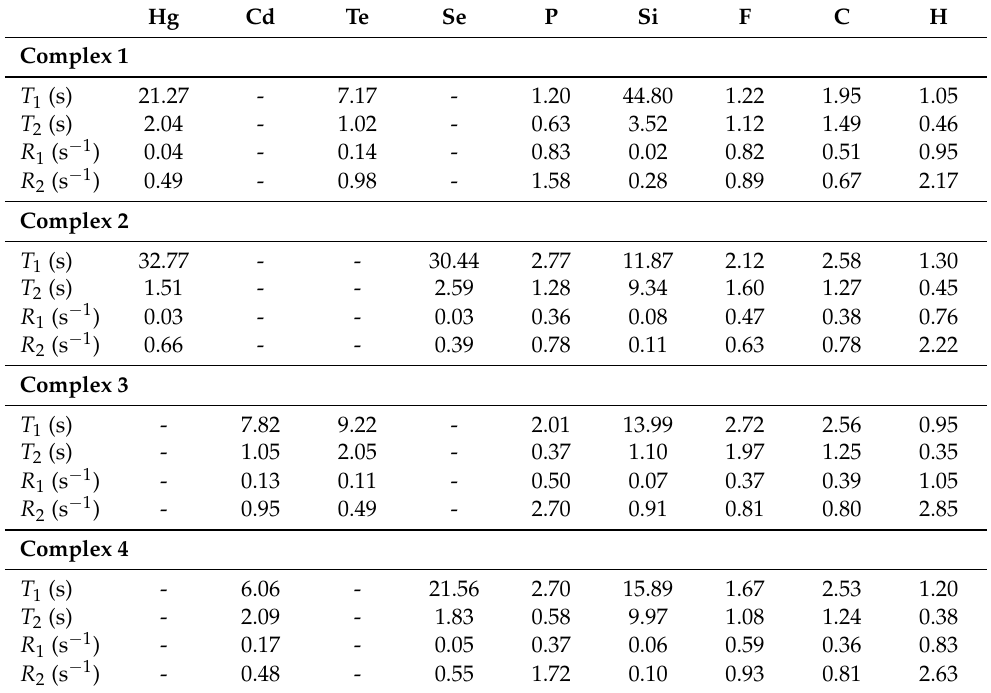
Table 6. Calculated relaxation times for the studied